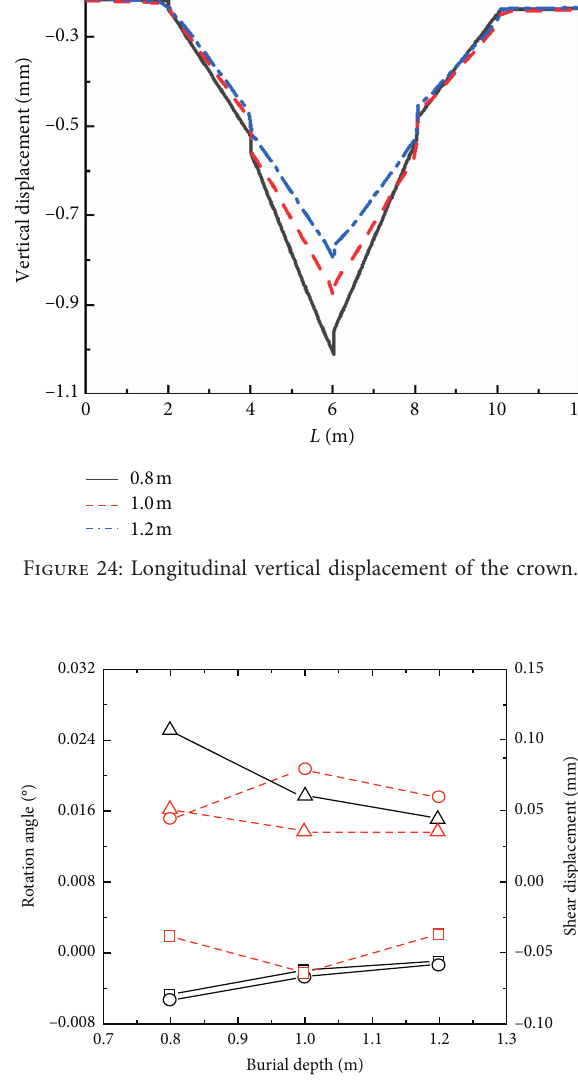
Rotation displacementJ2 Shear J3 Figure 25: Influence of burial depth on joint rotation under different burial depths and shear